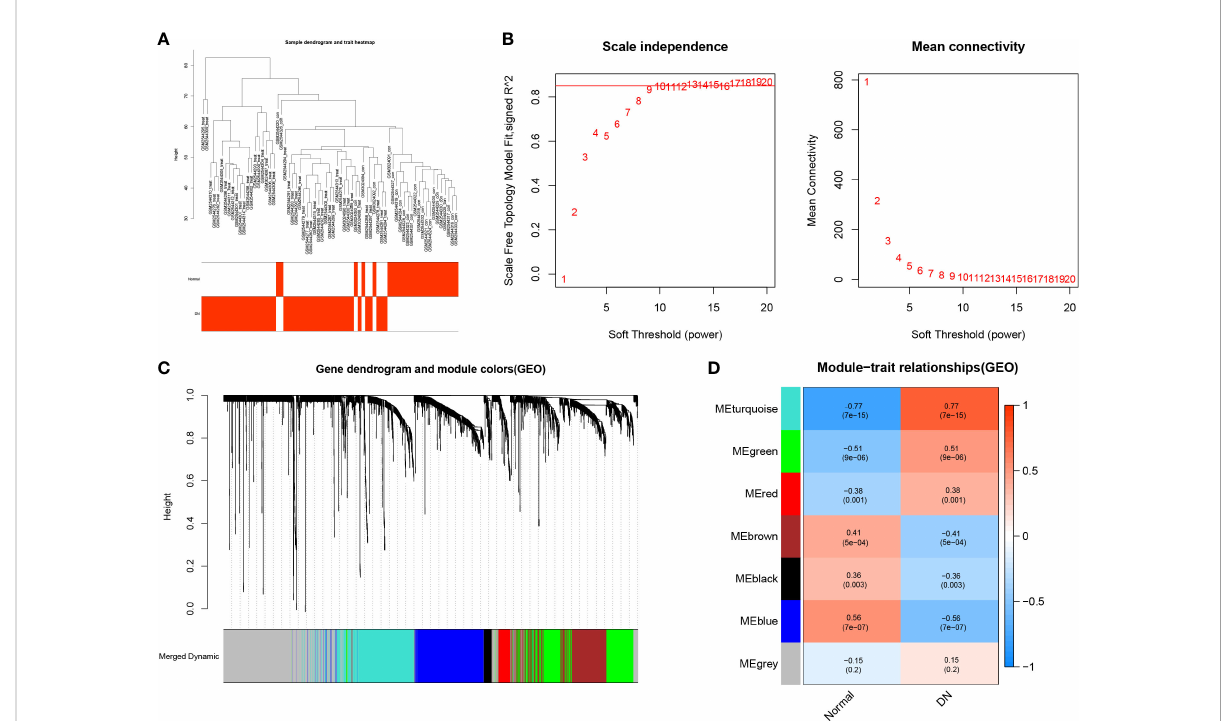
FIGURE 4 Weighted Gene Co-expression Network Analysis. (A) Clustering dendrogram of 69 samples. (B) Analysis of the scale free fi t index for different soft-thresholding powers ( b ), and analysis of the mean connectivity for different soft-thresholding powers. (C) Dendrogram of differentially expressed genes clustered based on a dissimilarity measure (1-TOM). (D) Heatmap of correlations between different modules and clinical traits, including normal tissues and DN